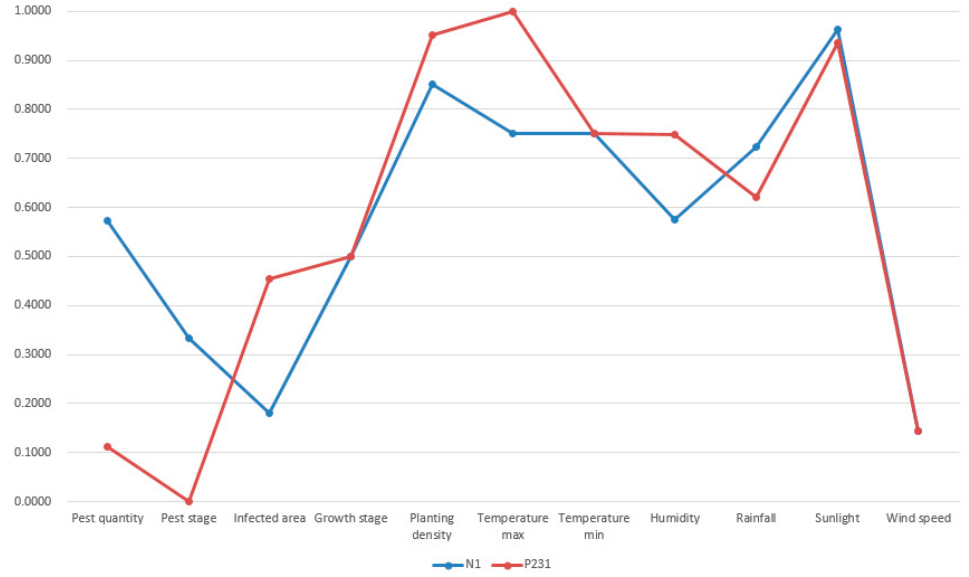
Figure 16. Visualization of the new case 1 and past case 231.